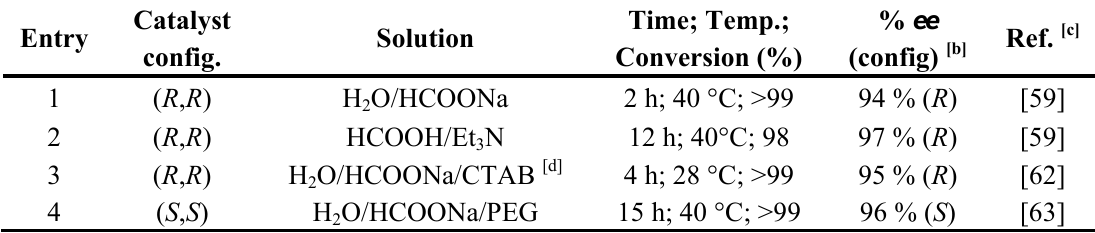
Table 2. ATH of acetophenone catalyzed by 1b in water [a]